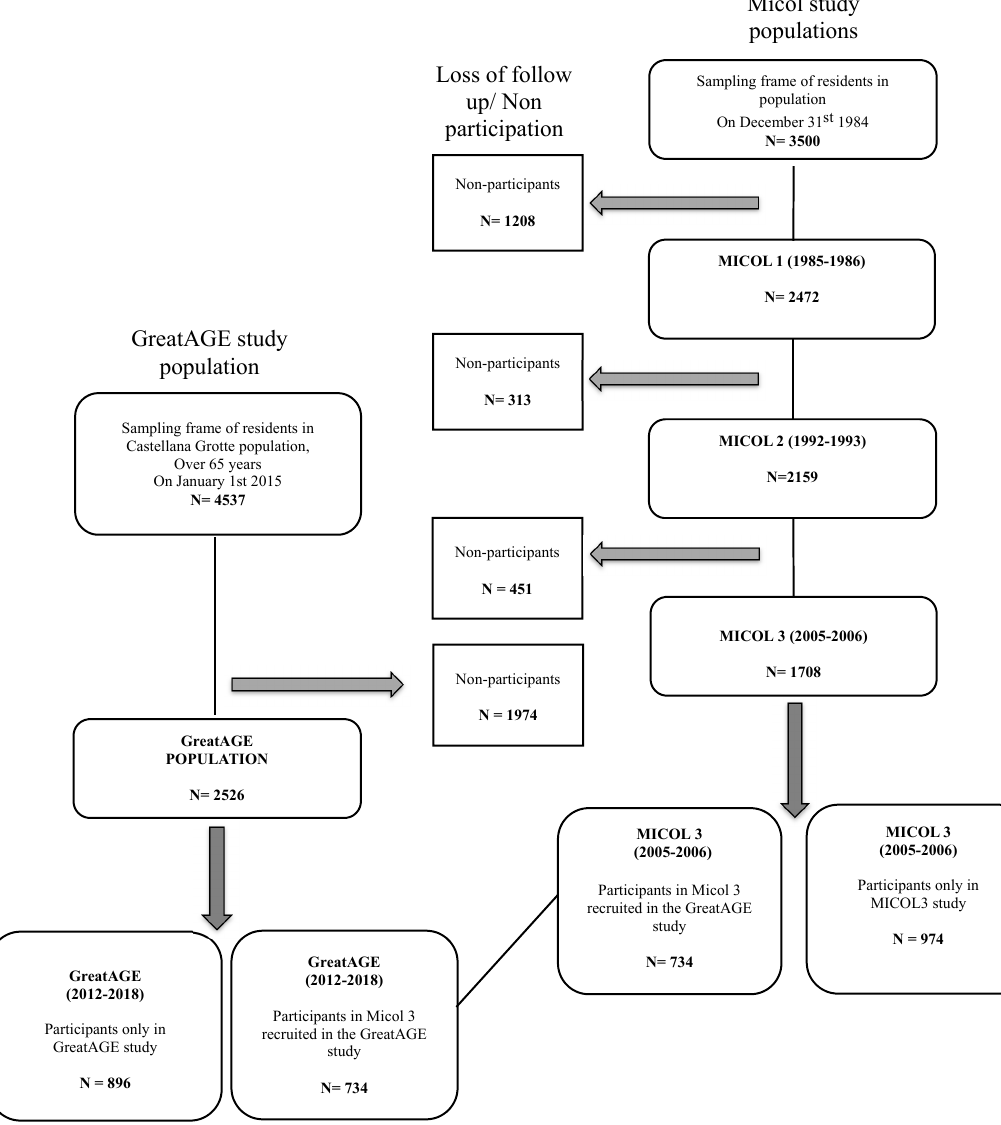
Figure 1. Flowchart of sample selection of Micol and GreatAGE studies. MICOL, Multicenter Italian study on